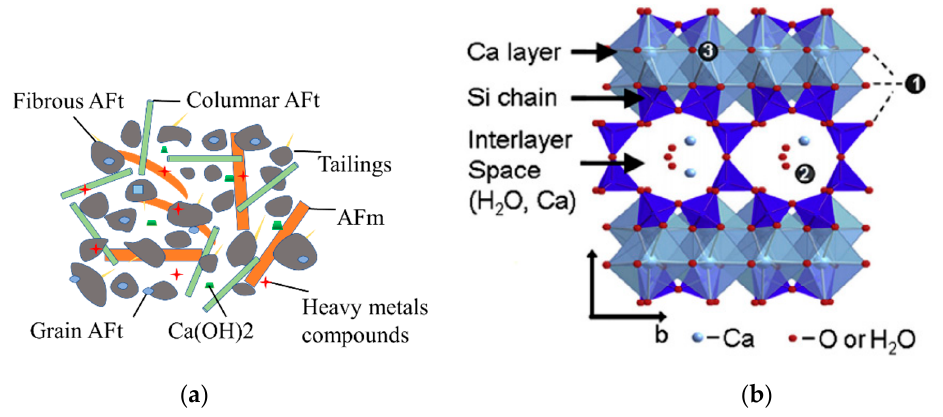
Figure 12. ( a ) Macro- and ( b ) molecular-scale illustrations of cement hydration adsorption mechanism for heavy metal ions.